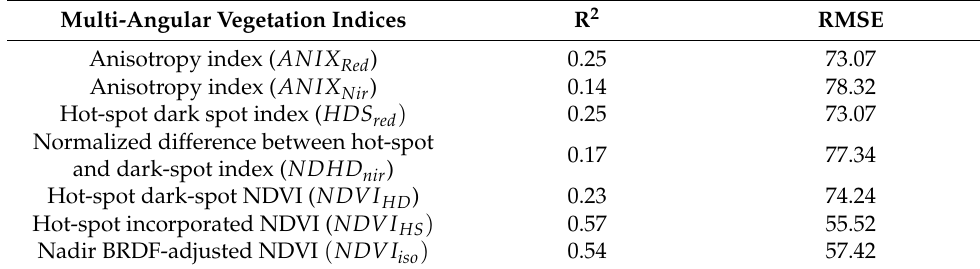
Table 2. Performance of existing multi-angular vegetation indices.